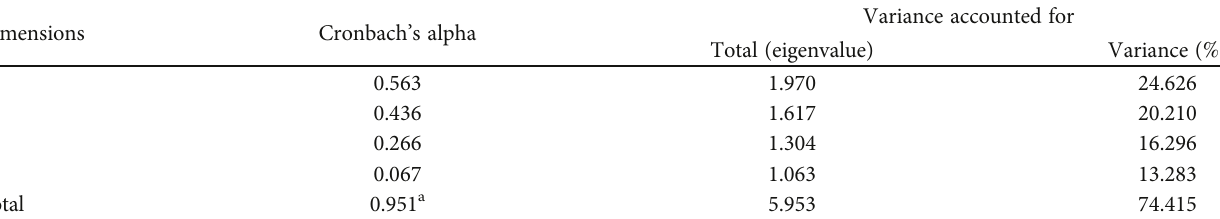
T ABLE 7: Model summary four